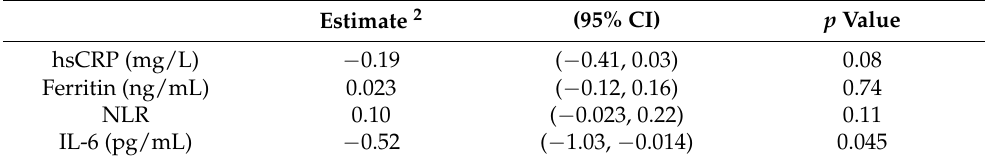
Table 2. Model-based effects of CURC treatment for four weeks on log-transformed biomarkers of inflammation in serum, compared to CON 1